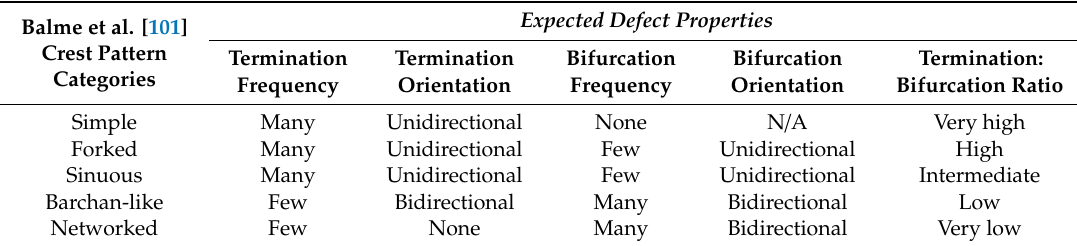
Table 3. Expected TAR defect